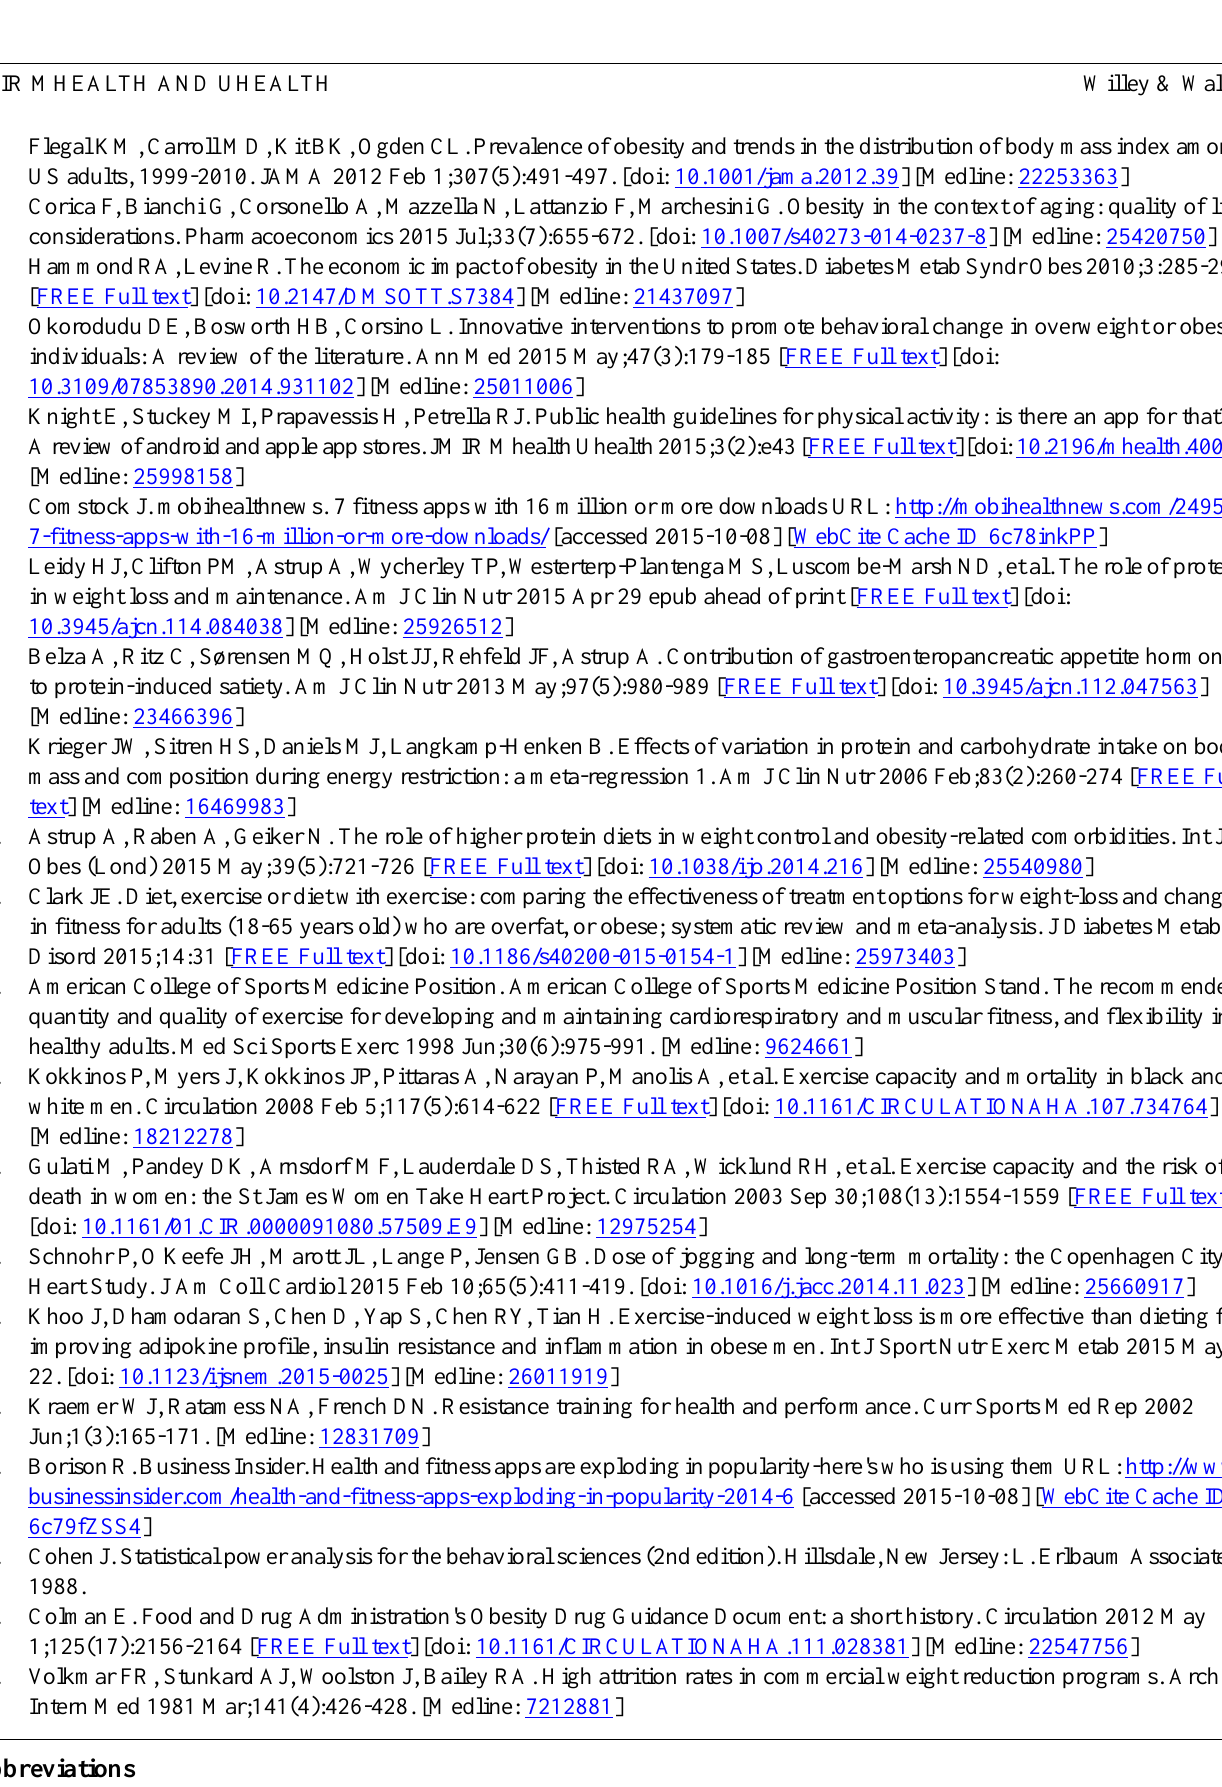
Abbreviations A1C: glycohemoglobin DBP: diastolic blood